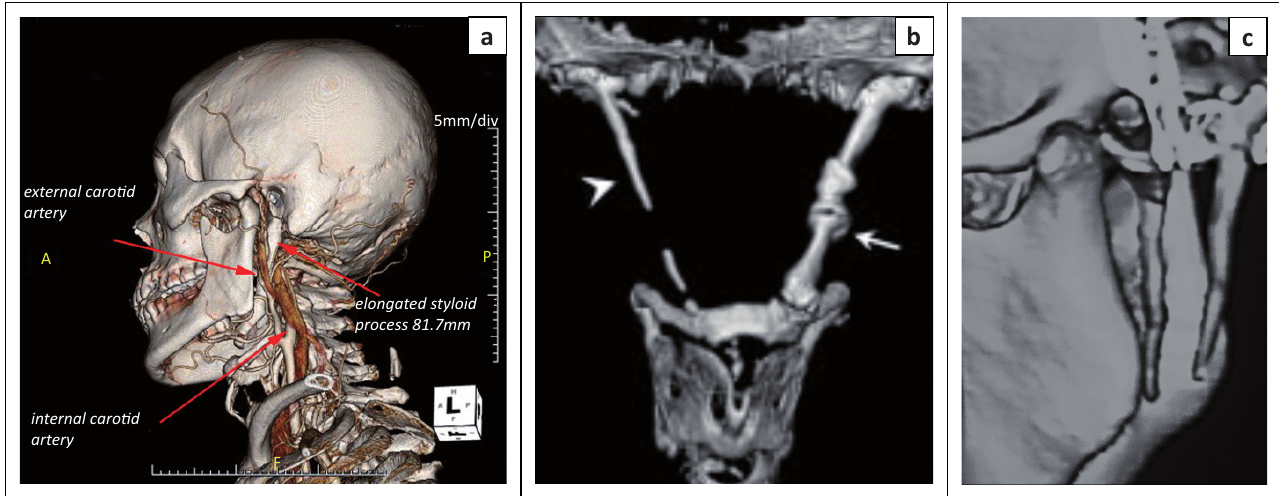
FIGURE 4: Various three-dimensional CT reconstruction images depicting elongation of the styloid process. 9,10 (a) 3DCT showing elongated styloid in association with vital structures, (b) 3DCT antero-posterior view, showing complete and partial calcification of stylohyoid ligament and (c) 3DCT depicting elongated styloid process.